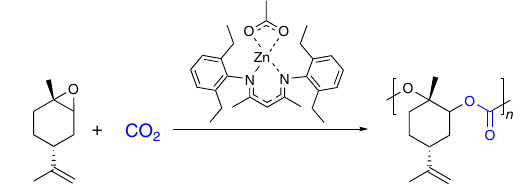
Figure 1 | Synthetic route towards PLimC. The copolymerization of limonene oxide and CO 2 in the presence of a b -diiminate zinc catalyst was discovered by Coates et al. 20 and optimized in our group to yield high-molecular-weight